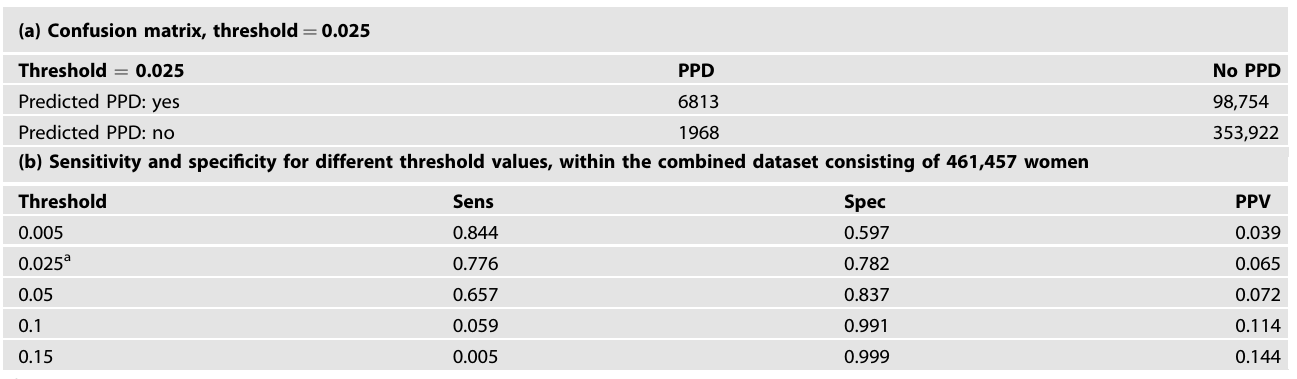
Table 5. Sensitivity and speci fi city in the recalibrated Extended model.